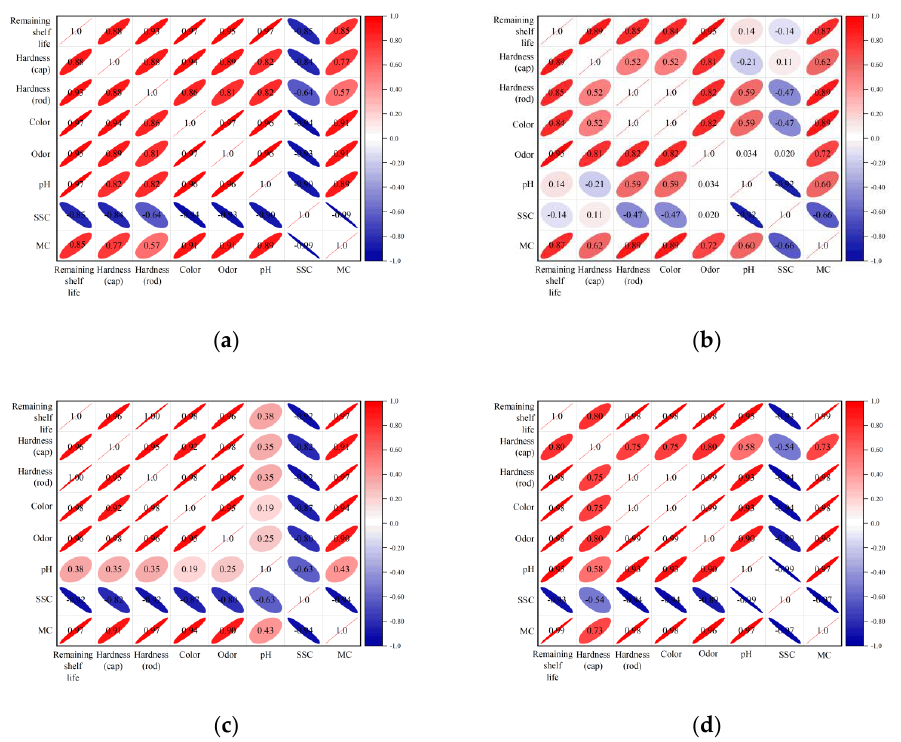
Figure 9. Correlation coefficients between matsutake quality indicators and remaining shelf life: ( a ) refrigeration preservation packaging at 0 °C; ( b ) refrigeration preservation packaging at 4 °C; ( c ) modified atmosphere packaging; ( d ) preservative preservation packaging.